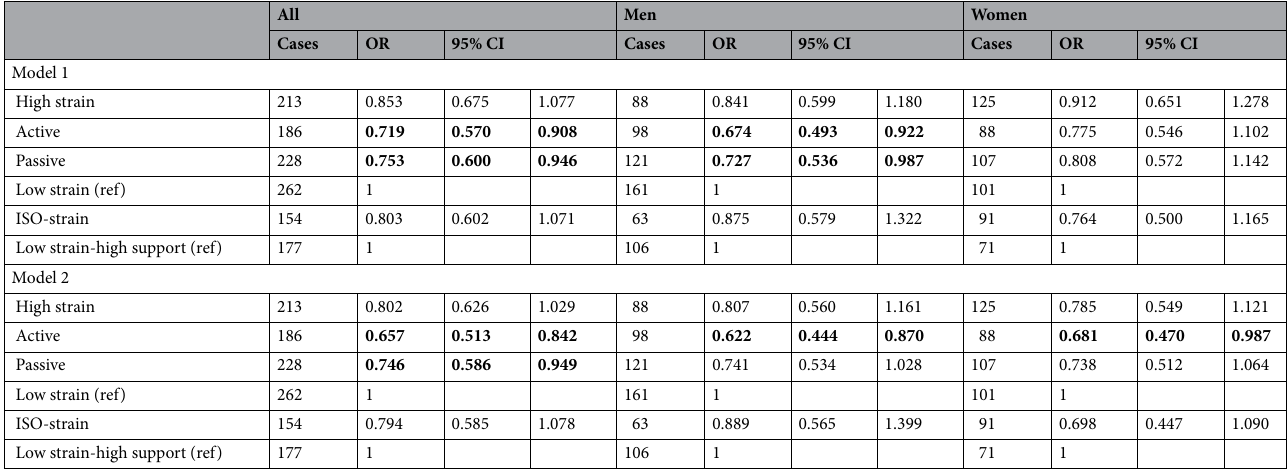
Table 2. Logistic regression job demand-control-social support and pre-diabetes (IGT + IFG + CGI) (n = 3322). Model 1: adjusted for age, education, smoking, alcohol, physical exercise. Model 2: model 1 + diabetes heredity, metabolic syndrome, BMI. Significant values are in